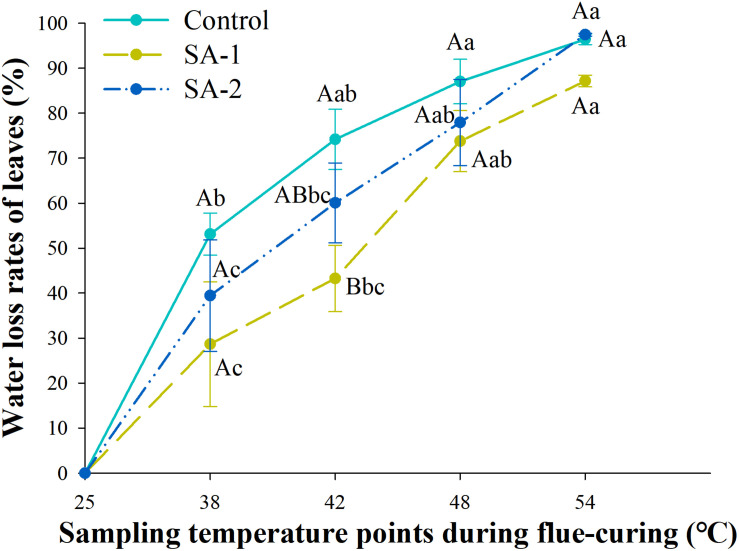
Change in water loss rate during bulk curing of flue-cured tobacco with different salicylic acid concentrations. Different capital letters indicate significant differences between treatments at the same stage (P < 0.05). Different lowercase letters indicate significant differences between the same treatments at different curing stages. Values represent the averages of three biological replicates. Data are presented as means ± standard error (n = 3).